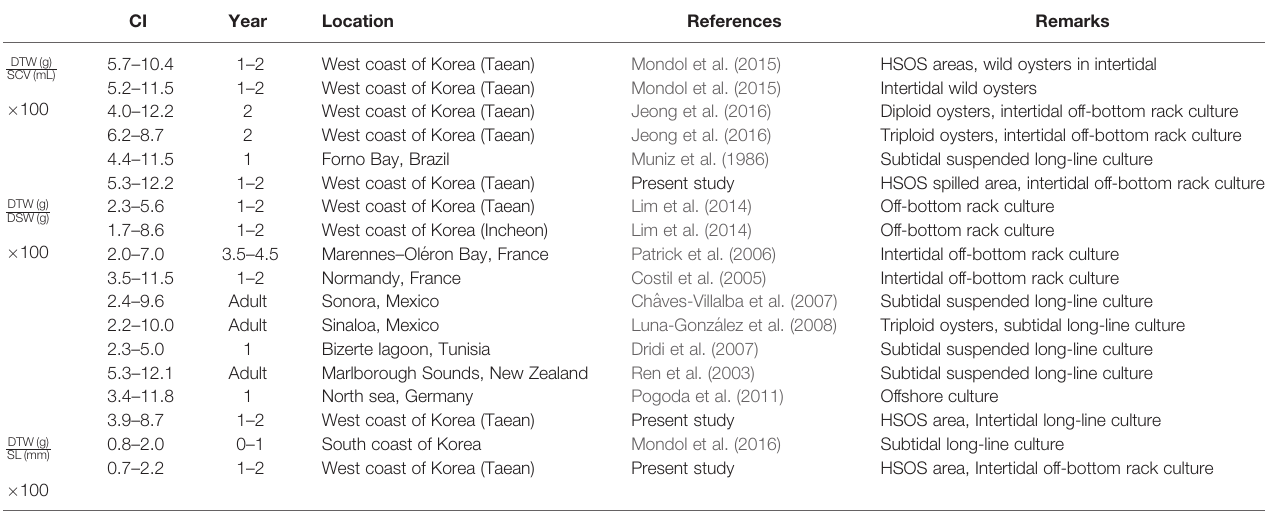
TABLE 3 | Summary of the condition index (CI) of Crassostrea gigas previously reported from elsewhere and the present study.